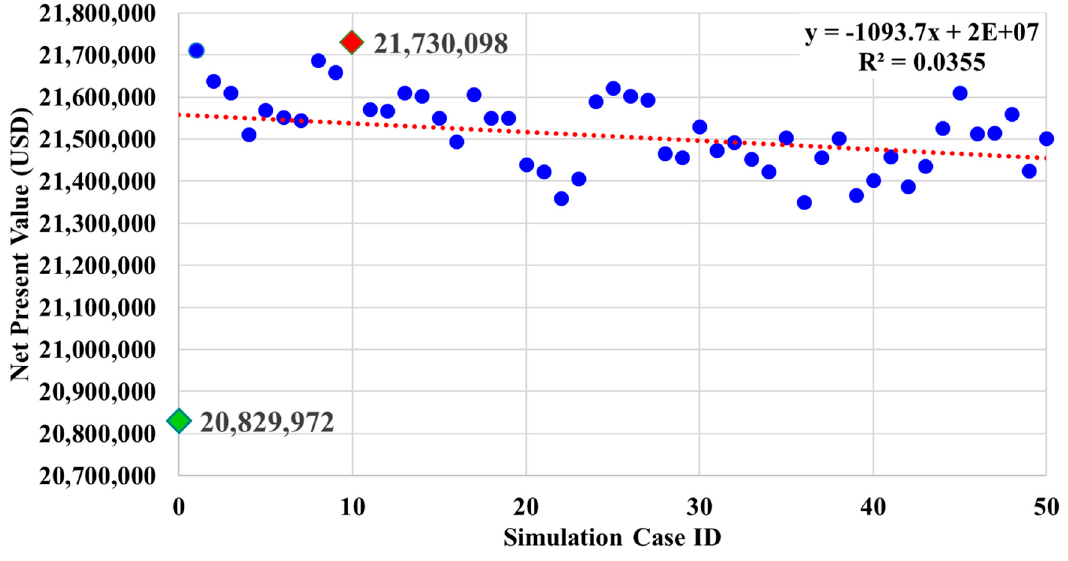
Figure 5. Long-term optimization